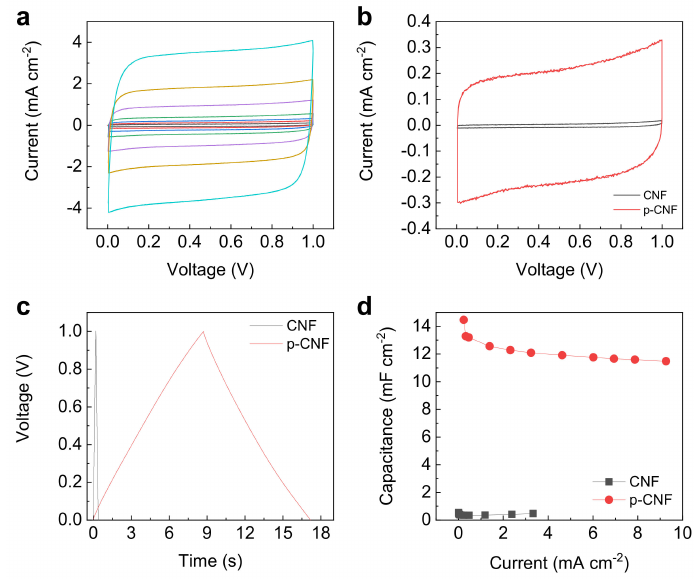
Figure 4. ( a ) Cyclic voltammetry (CV) curves of p-CNF electrode at scan rates of 10 to 1000 mV s − 1 . ( b ) CV curves (at a constant scan rate of 50 mV s − 1 ), ( c ) galvanostatic charge / discharge (GCD) profiles (at a constant current of 0.5 mA cm − 2 ), and ( d ) rate-retention capability of CNF and p-CNF